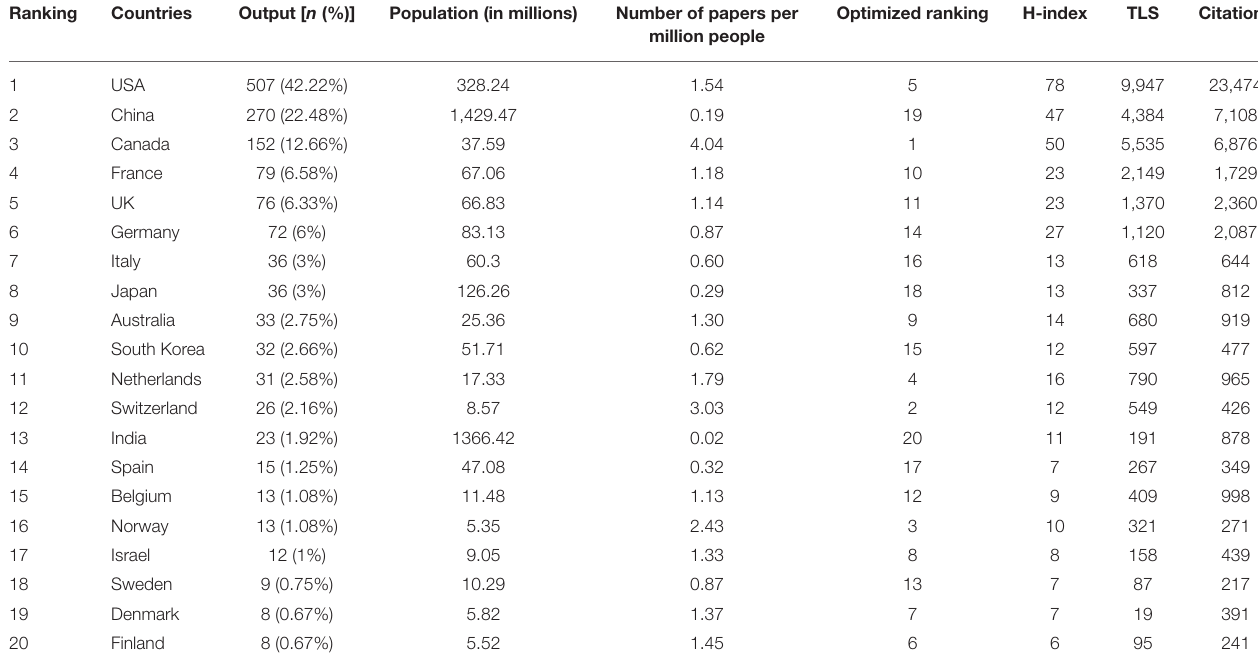
TABLE 2 | The top 20 productive countries in the publications concerning ultrasound-induced BBB opening research. Ranking